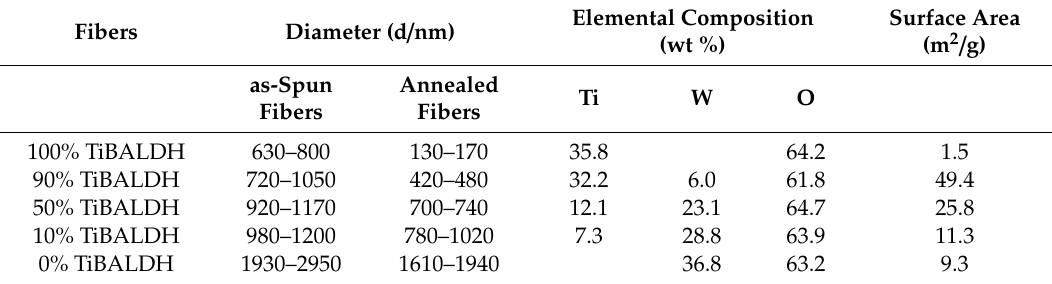
Figure 3 . SEM images of annealed fibers ( a ) 0% TiBALDH, ( b ) 10% TiBALDH ( c ) 50% TiBALDH, ( d ) 90% TiBALDH, and ( e ) 100% TiBALDH. Table 1. The diameter of as-spun and annealed fibers, elemental composition and specific surface area of annealed fibers.